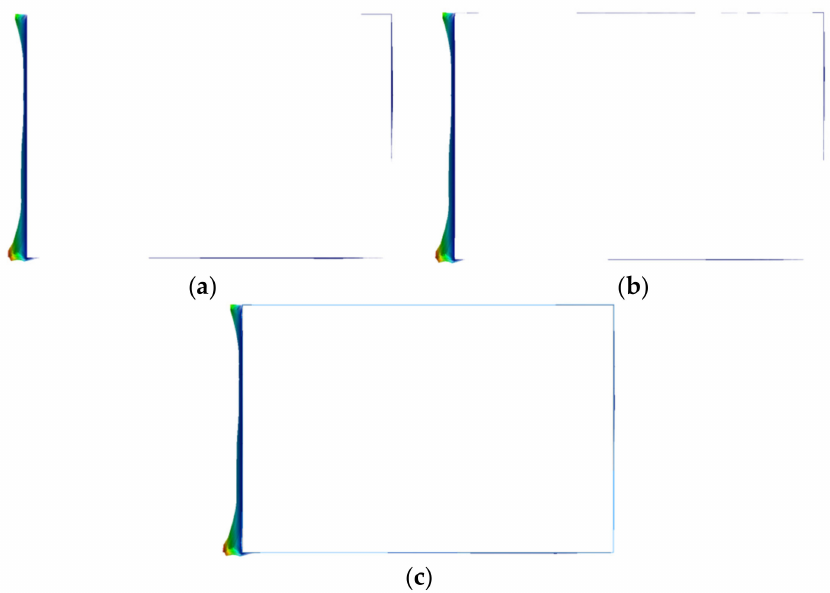
Figure 13. The ice distributions at different time steps. ( a ) The time steps are 120 s. ( b ) The time steps are 240 s. ( c ) The time steps are 480 s.